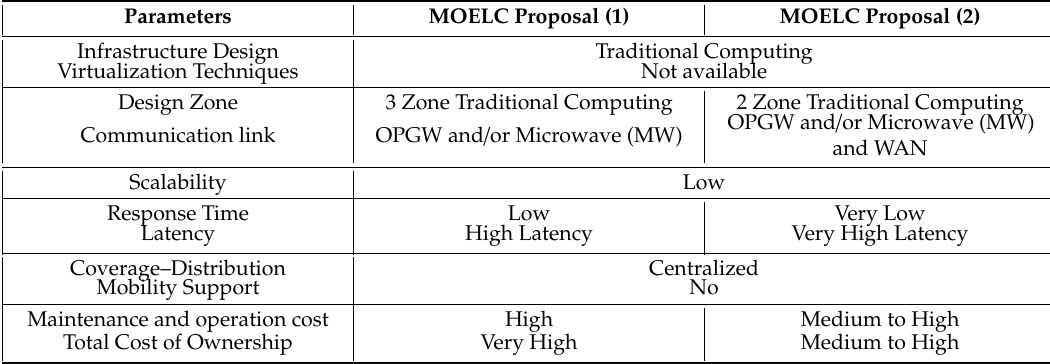
Table 2. Comparison between MOELC Proposals 1 and